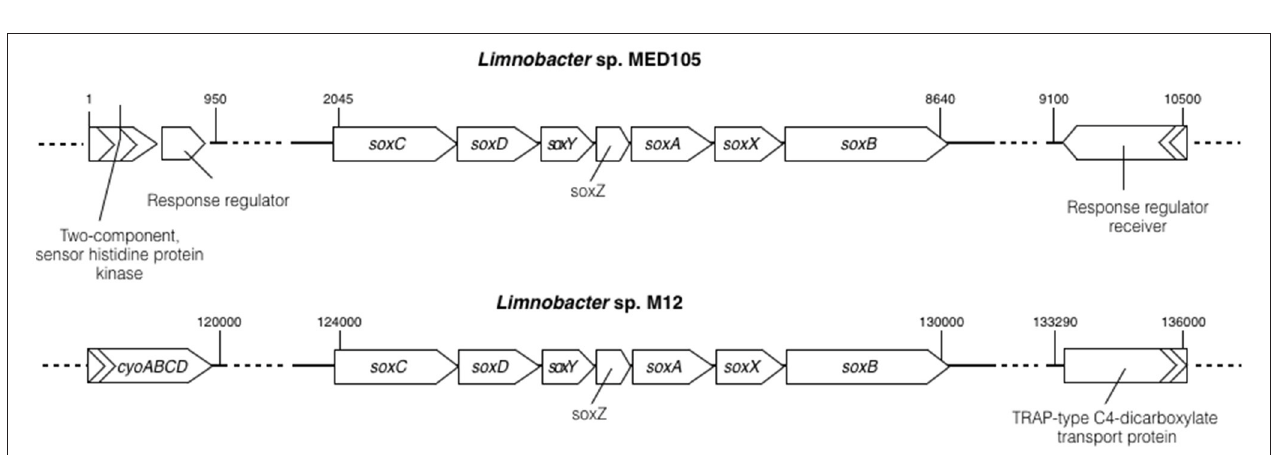
FIGURE 3 | Comparison of the sulfur-oxidizing system locus ( sox ) in Limnobacter sp. MED105 and Limnobacter sp. M12. The organization of sox genes, including soxCDYZAXB , is similar in both MED105 and M12, but the flanking genes are different. CyoABCD represents genes encoding cytochrome o ubiquinol oxidase, which is involved in oxidative phosphorylation. Numbers on the top of the gene clusters represent the base numbers on the assembly.